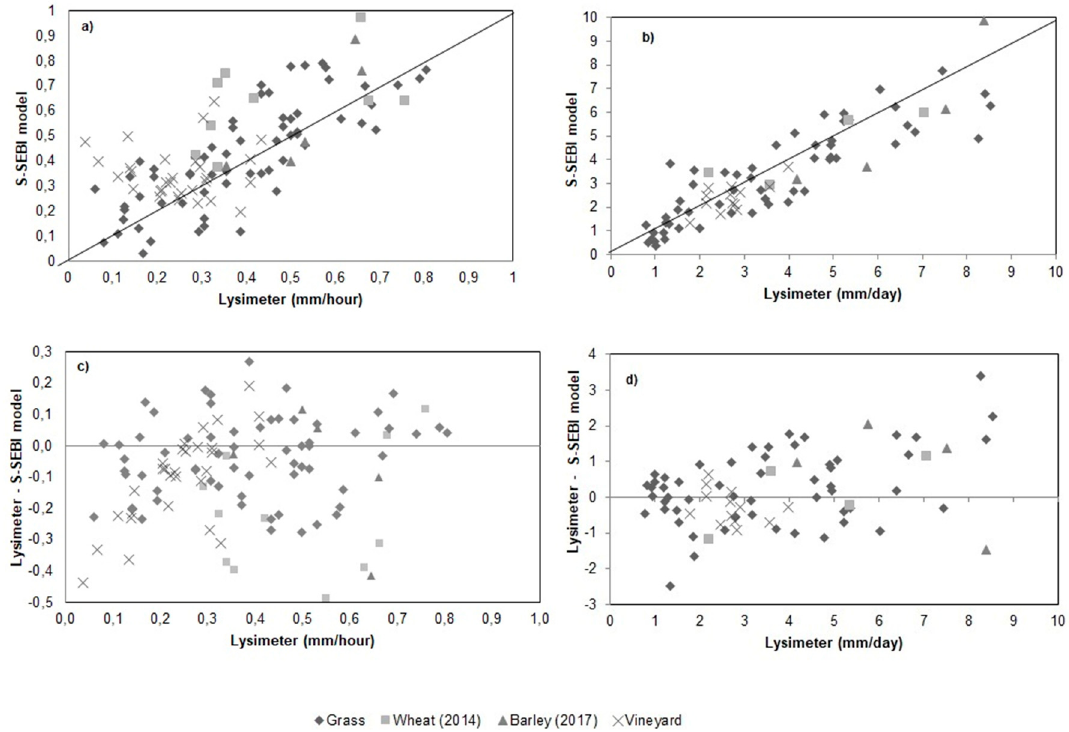
Figure 3. ( a ) Hourly ET correlation analyses, ( b ) daily ET correlation analyses between S-SEBI model and lysimeter data, ( c ) relationship between hourly ET bias and lysimeter data, and ( d ) daily ET bias and lysimeter data measurements. Line 1:1 is included.